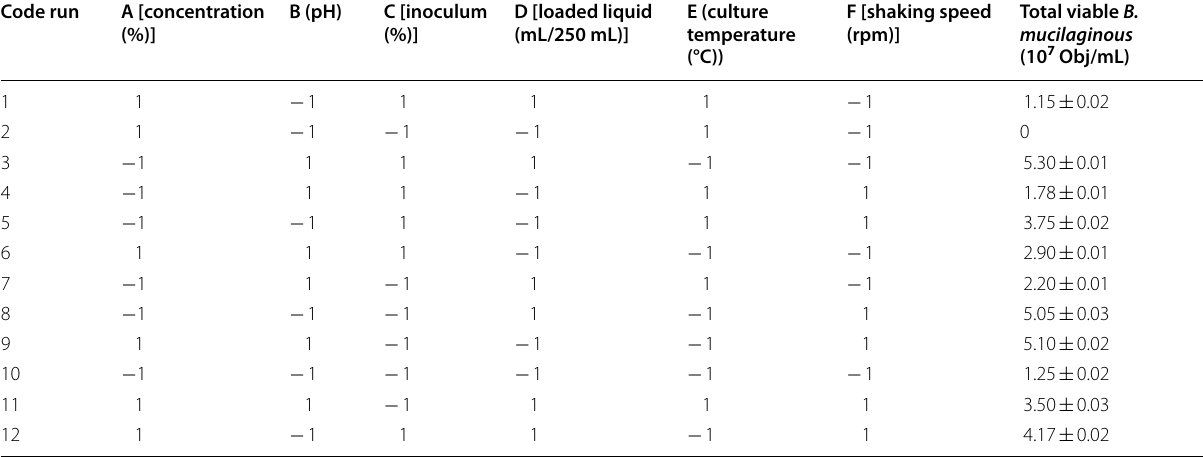
Table 2 Plackett–Burman experimental design Code